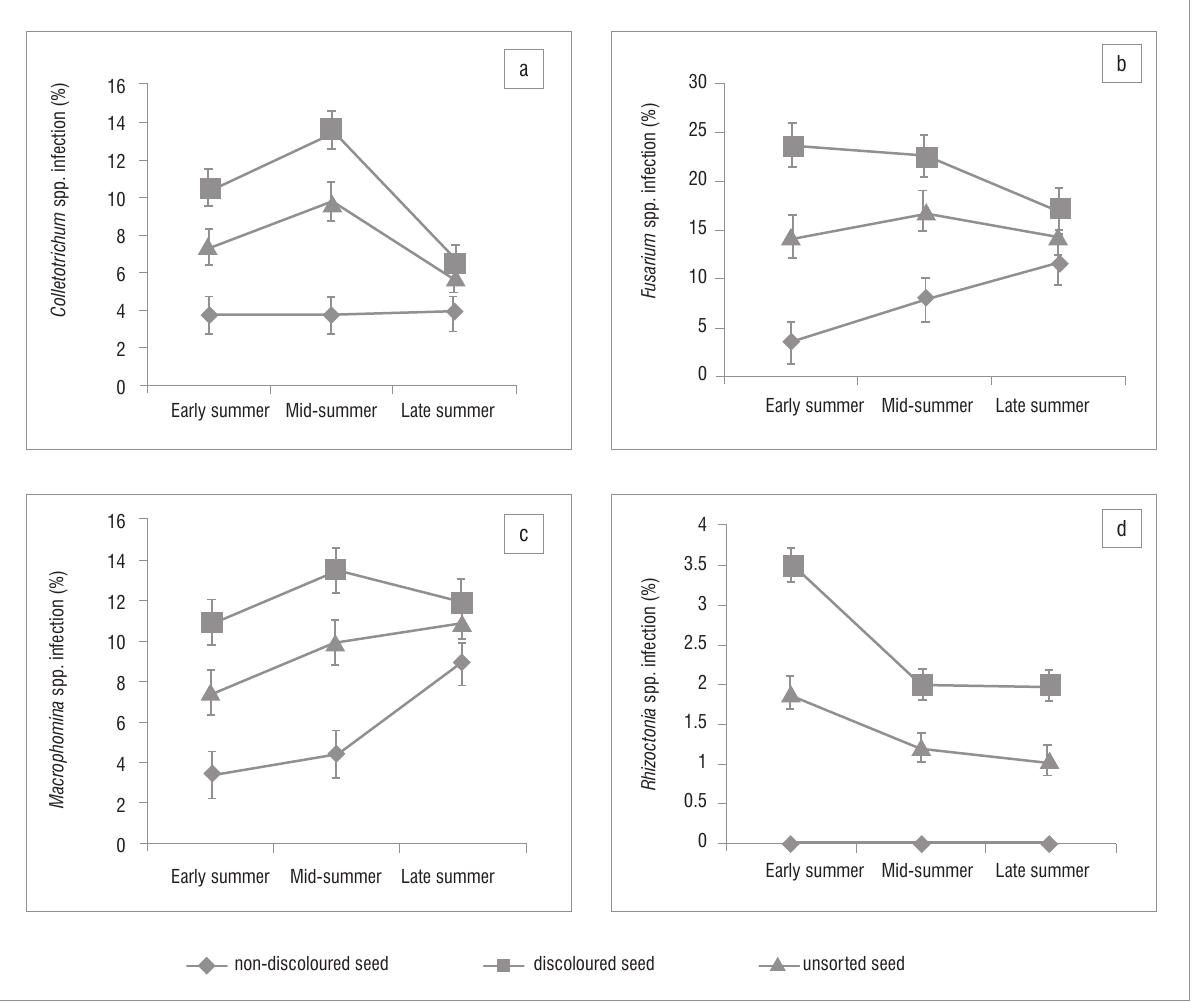
Figure 3: Interaction effect of planting date and seed category on seed infection by (a) Colletotrichum spp. , (b) Fusarium spp. , (c) Macrophomina spp . and (d) Rhizoctonia spp